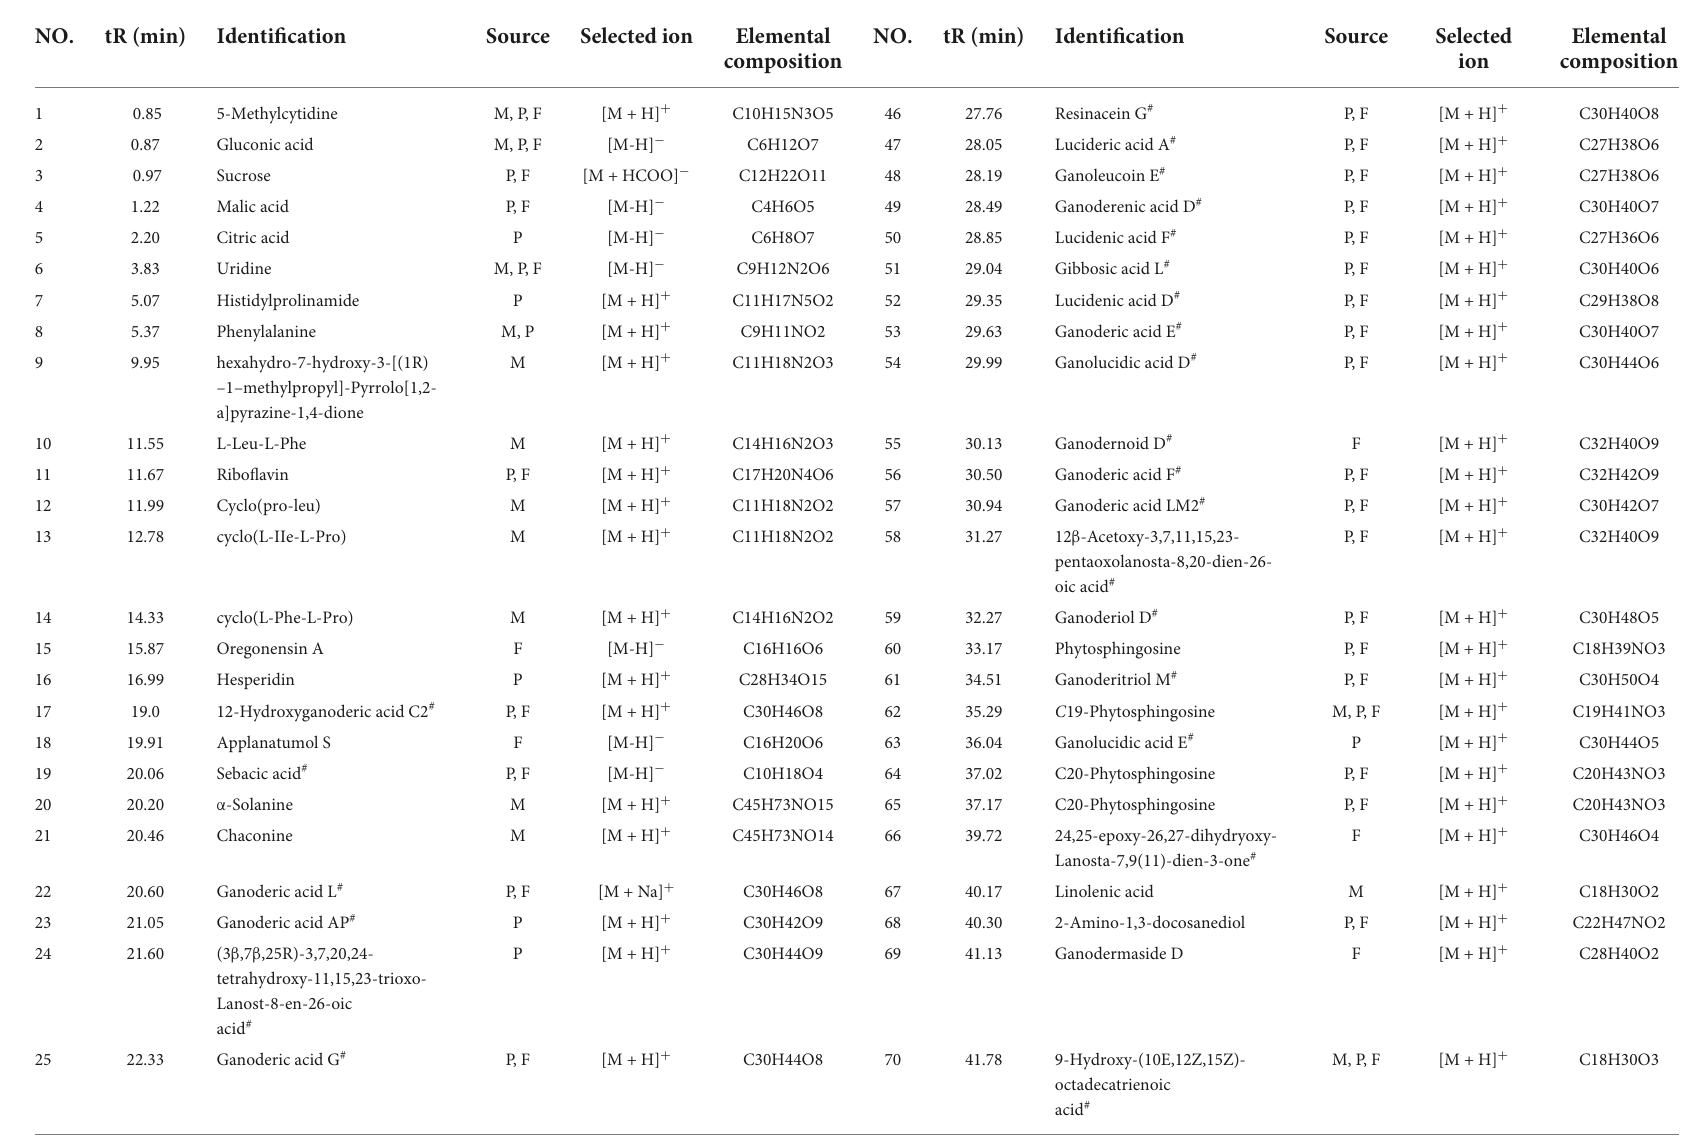
TABLE 2 Chemical analysis of G. lucidum in different growth